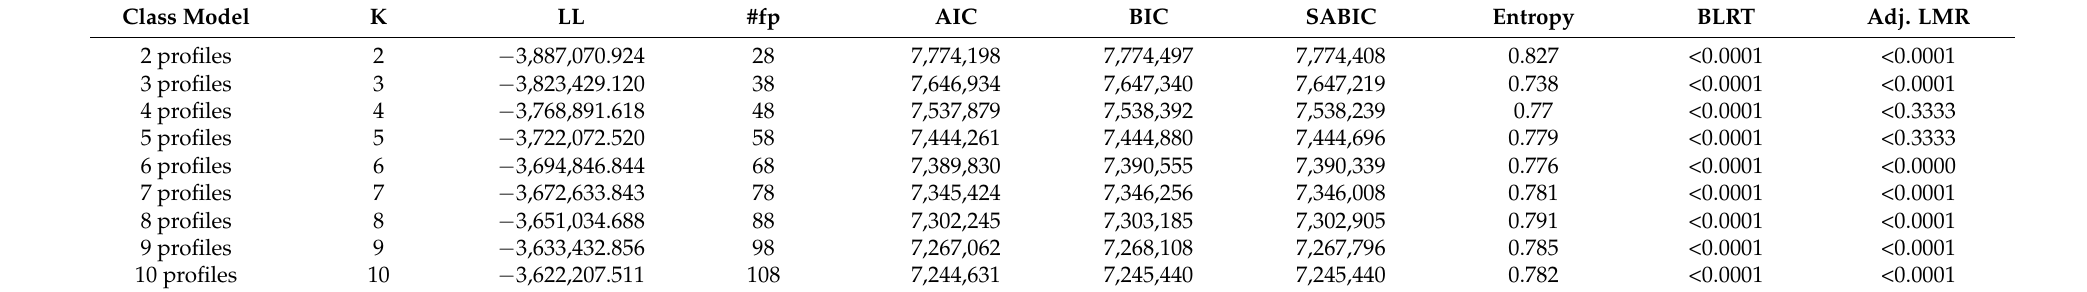
Table 2. Latent profile analysis model fit